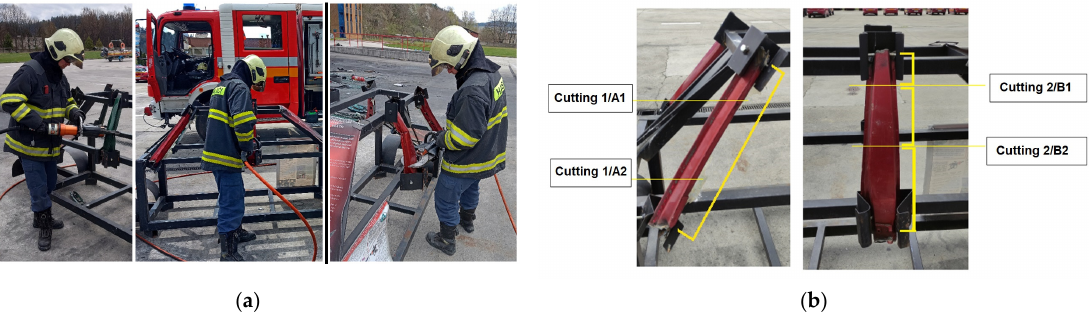
Figure 8. ( a ) Testing of the prototype training device, ( b ) location of designated cutting points.